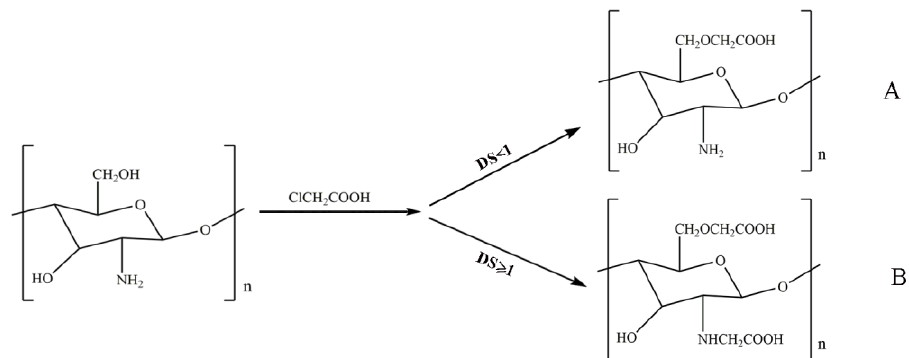
Figure 4. Carboxylated chitosan derivative reaction equation. ( A ) O-carboxymethyl chitosan (degree of substitution (DS) < 1); ( B ) N, O-carboxymethyl chitosan (DS ≥ 1).